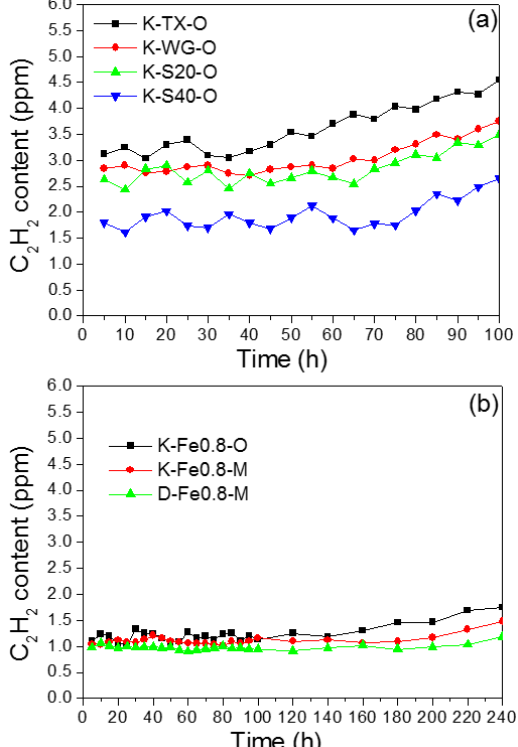
Figure 7. Long-term stability test during catalytic abatement of acetylene through hydrochlorination over prepared samples ( a ) K-TX-O, K-WG-O, K-S20-O, K-S40-O ( t = 100 h); and ( b ) K-Fe0.8-O, K-Fe0.8-M, D-Fe0.8-M ( t = 240 h); at T = 160 °C, total pressure of 0.3 Mpa, GHSV = 10 mL min − 1 g − 1 , t = 100 h; and 2000 ppm C 2 H 2 balanced by HCl (>99.5%); error bar of 5%.